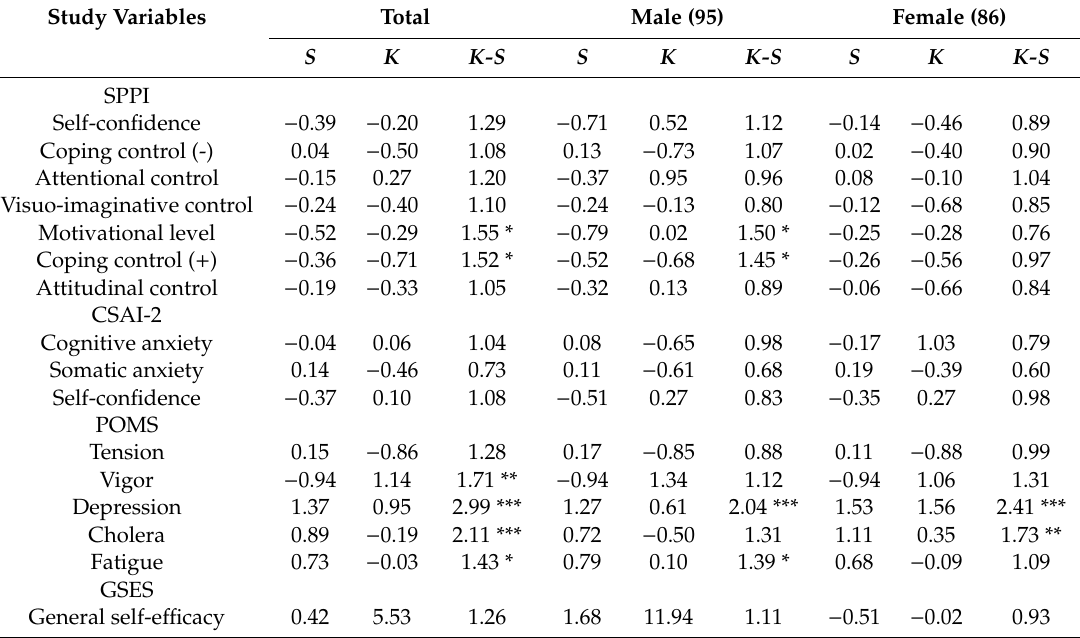
Table 2. Normality analysis of SPPI, CSAI-2, POMS and GSES scores. Study